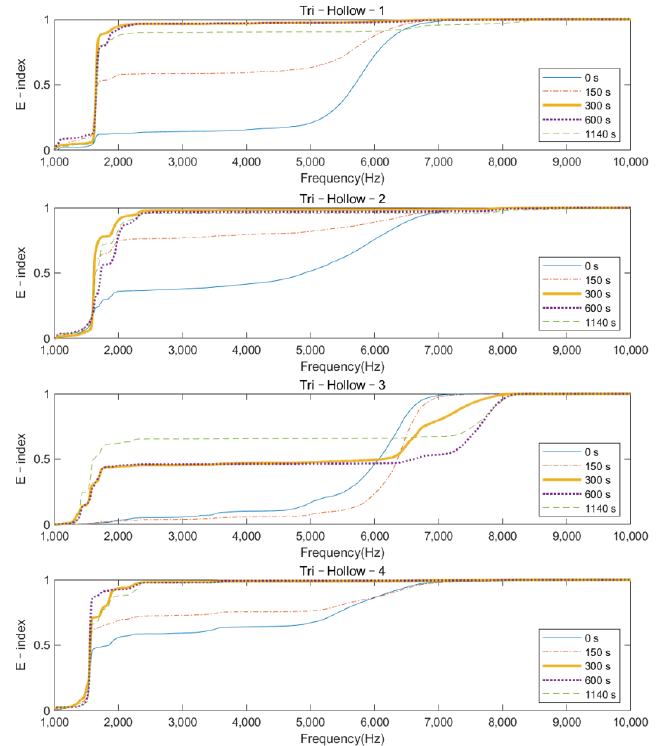
Figure 12. E–index as the function of frequency at five different times (0, 150, 300, 600, and 1140 s) for a hollow IM stem condition.